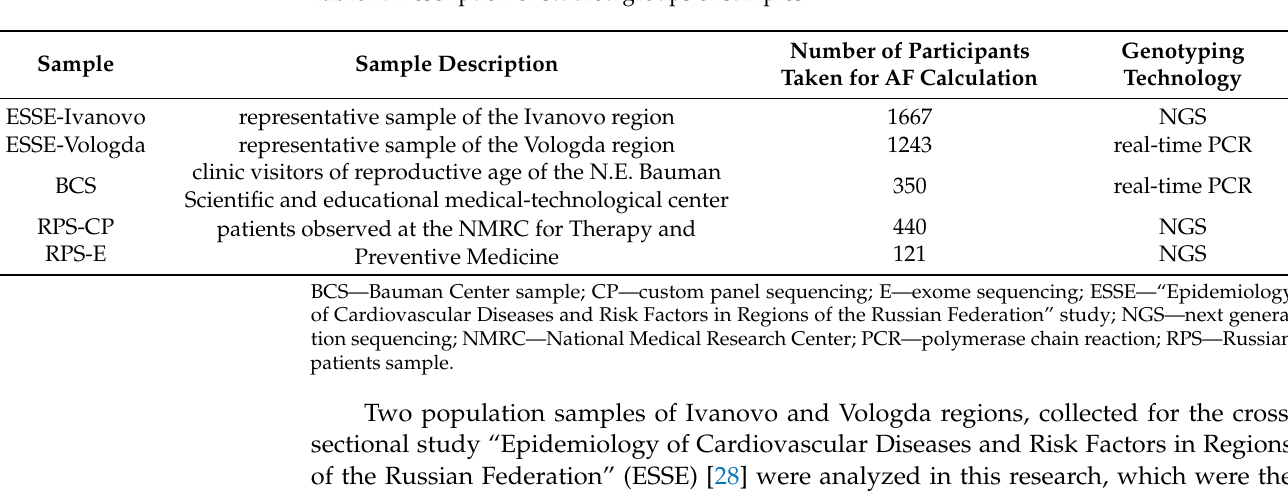
Table 1. Description of studied groups of